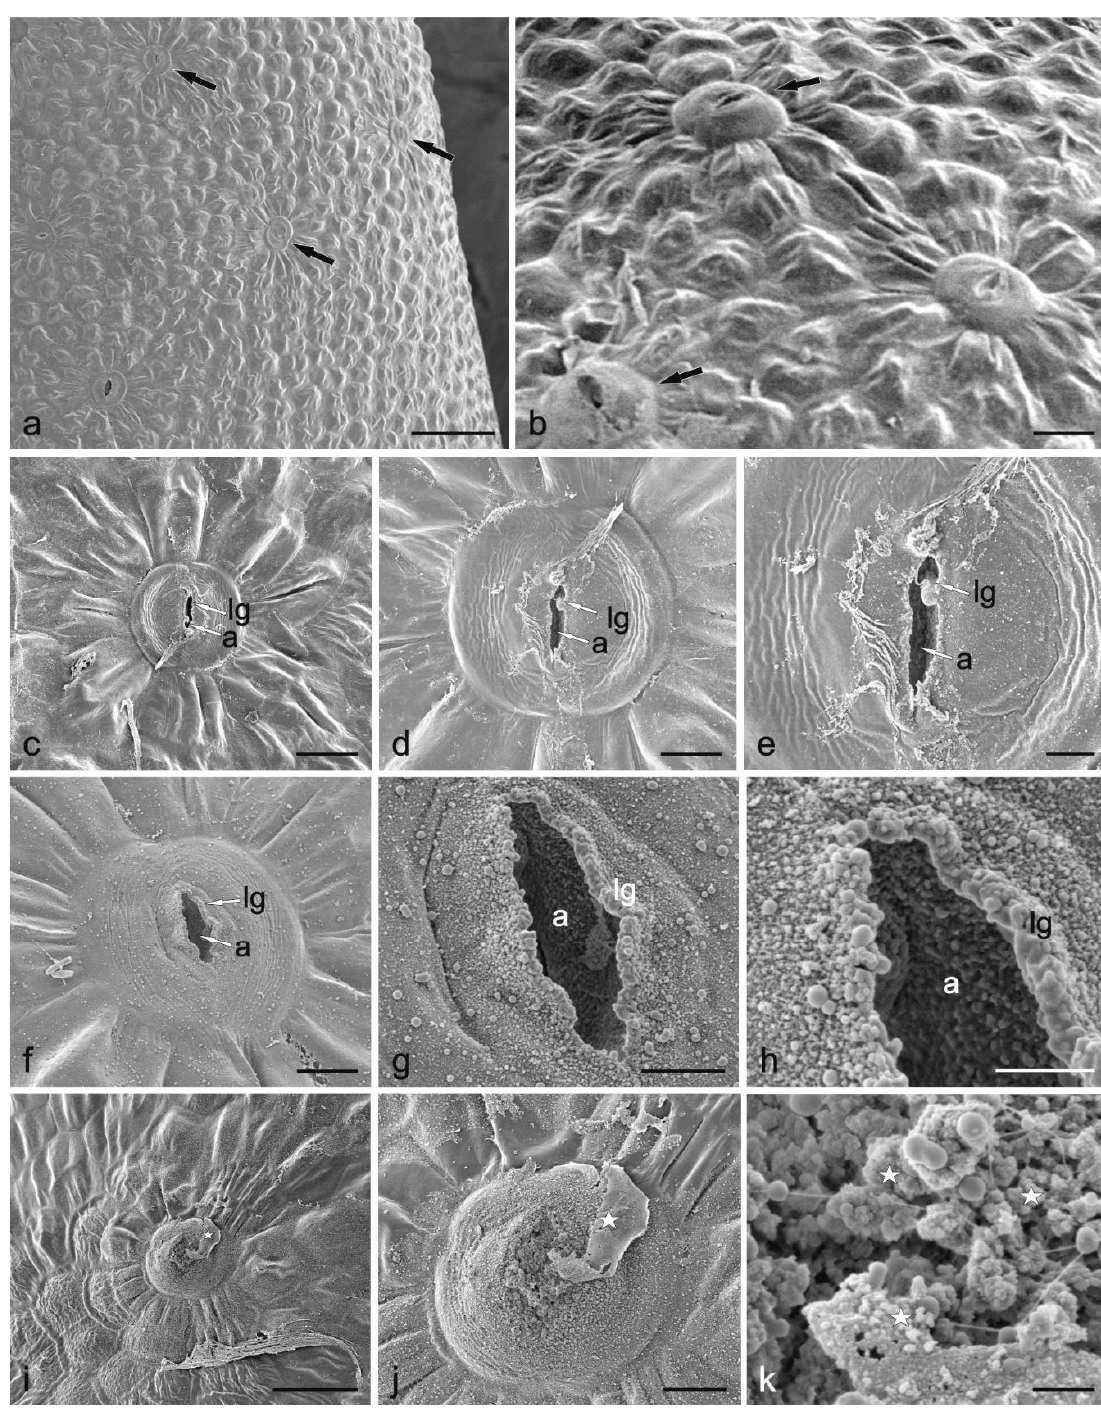
Figure 3. Nectarostomata on the abaxial surface of the longer lobe of the Dracocephalum moldavica nectary (SEM). ( a ) A part of the epidermis with nectarostomata before nectar secretion (arrows); ( b ) Nectarostomata with an open pore at the beginning of nectar secretion (arrows); ( c – e ) Stoma in the aperture and ledge formation stage (various magnifications); ( f – h ) Stoma with formed ledges during nectar secretion (various magnifications); ( i – k ) Stoma with an aperture occluded by nectar residues (stars); a—aperture; lg—ledge. Scale bars: 50 µ m ( a ), 20 µ m ( i ), 10 µ m ( b , c ), 5 µ m ( d , f , j ), 2 µ m ( e , g ), 1 µ m ( h ), 0.5 µ m ( k